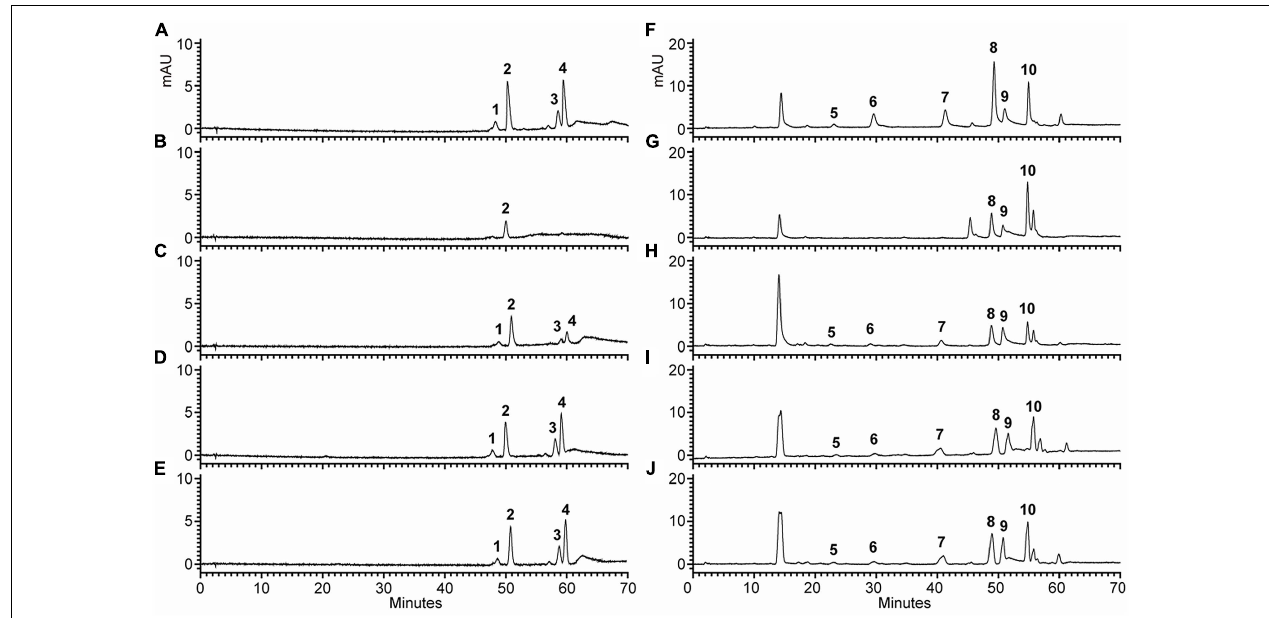
FIGURE 7 | High performance liquid chromatography analyses of anthocyanins and flavonols in transgenic Arabidopsis seedlings. (A–J) . HPLC chromatograms of the samples from seedlings of wild type, mutant and transgenic lines. (A,F) wild type, (B,G) Mutant, (C,H) NO.5, (D,I) NO.9, (E,J) NO.12. (A–E) Absorbance at 520 nm for analysis of anthocyanins. (F–J) Absorbance at 360 nm for analysis of